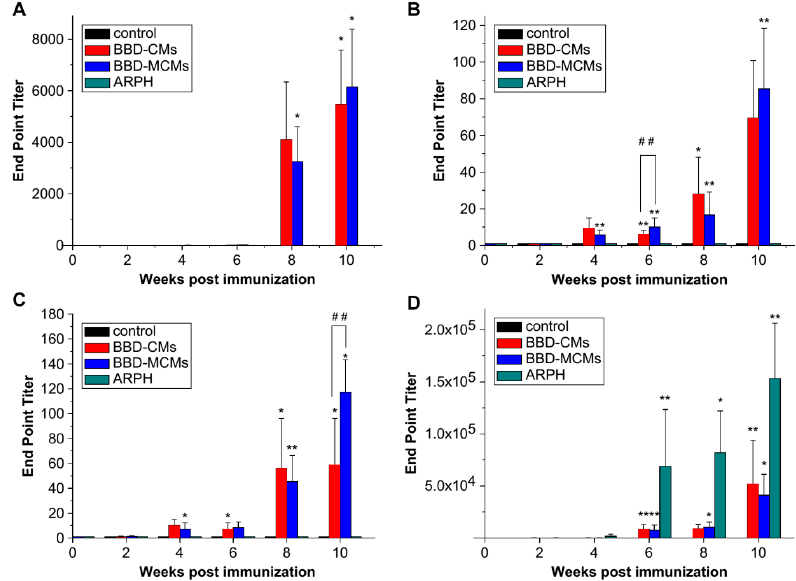
Figure 10. Anti-BBD IgA levels in ( A ) nasal wash; ( B ) saliva (data are means ± standard deviations, n = 3). A significant difference between untreated and immunized groups was expressed as * p < 0.001, significant differences between untreated and immunized groups were expressed as * p < 0.001 and ** p < 0.05 and between BBD–CMs and BBD–MCMs groups as ## p < 0.05; ( C ) anti-BBD IgA levels in serum; ( D ) anti-BBD IgG levels in serum (data are means ± standard deviations, n = 3). Significant differences between untreated and immunized groups were expressed as * p < 0.001